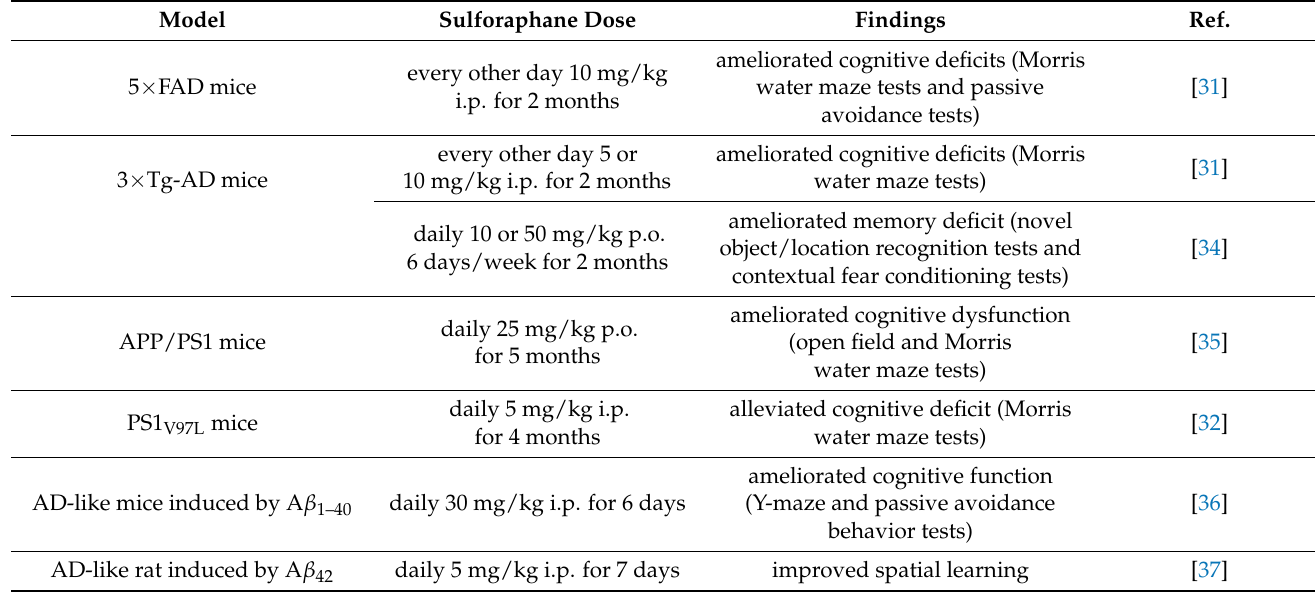
Table 6. The effects of sulforaphane on cognitive impairment in Alzheimer’s disease (AD)-like animal models.